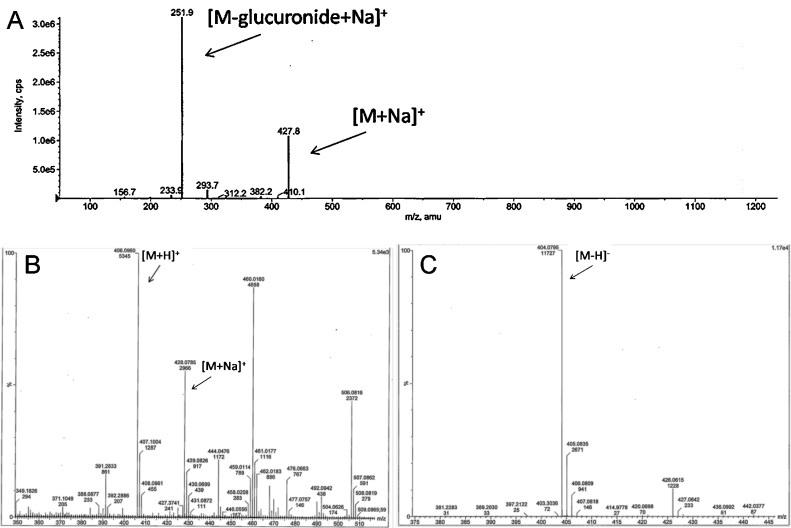
Analysis of urine metabolite M6 by mass spectrometty in positive ion ESI-MS A) MS spectrum of metabolite M6 showing sodium adduct (m/z 428) and an ion corresponding to the loss of glucuronidemoiety (m/z 251) (B) positive ion MS/MS spectrum of metabolite M6 (C) negative ion MS/MS spectrum of metabolite M6.